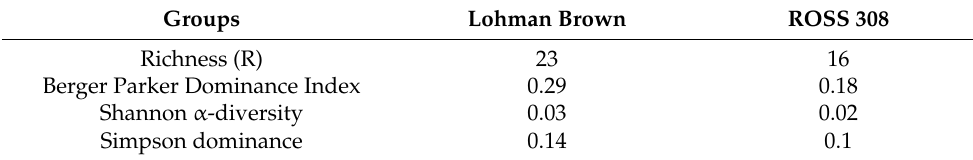
Table 2. Bacterial biodiversity characteristics of the analyzed breeds.